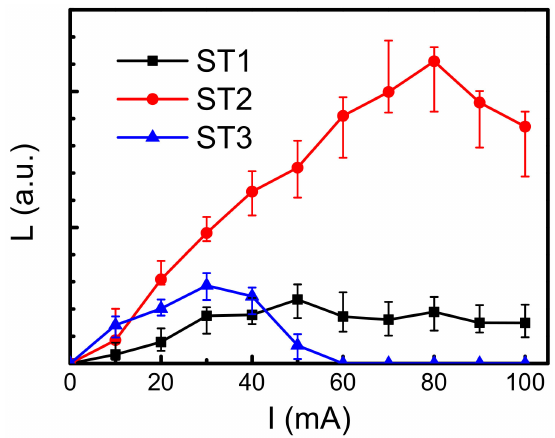
Figure 7. The light intensity-current (L-I) characteristics of samples ST1, ST2, and ST3 measured at room temperature.